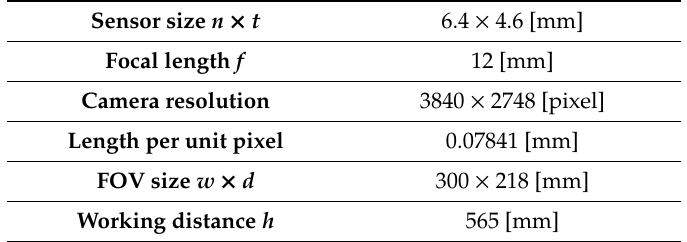
Table 2. Specifications of the machine-vision camera and lens. FOV, field of view.